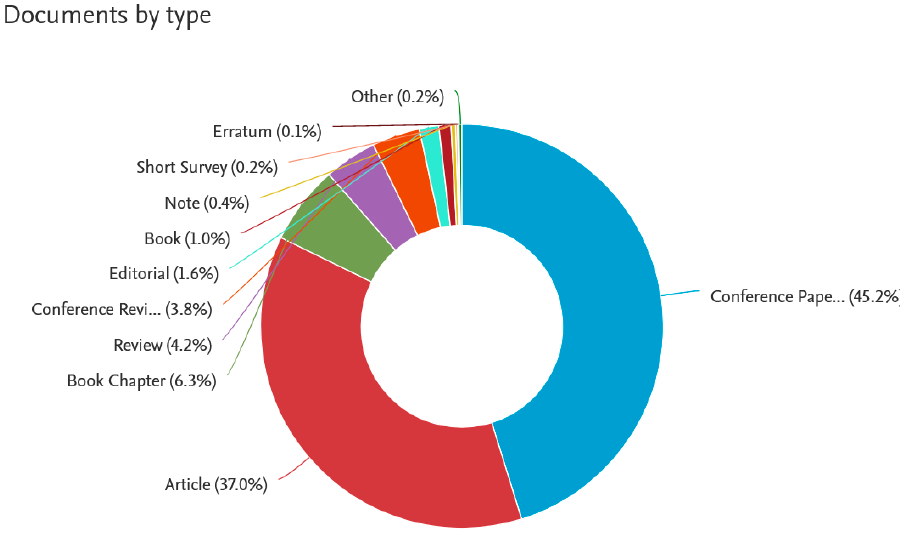
Figure 7. Documents found in Scopus for the “big data analytics” key phrase by document type.